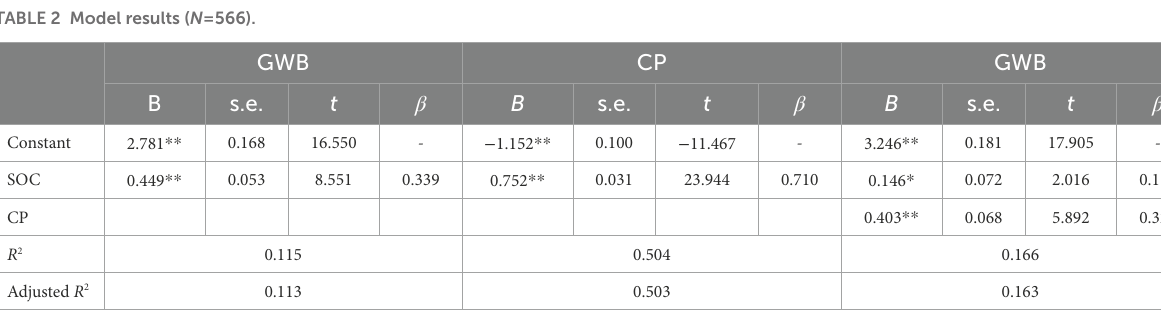
TABLE 2 Model results ( N = 566).